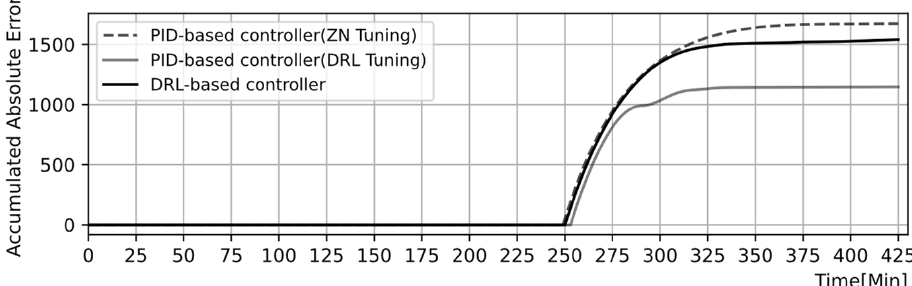
Figure 22. Comparisons of controllers for the pressurizer level.